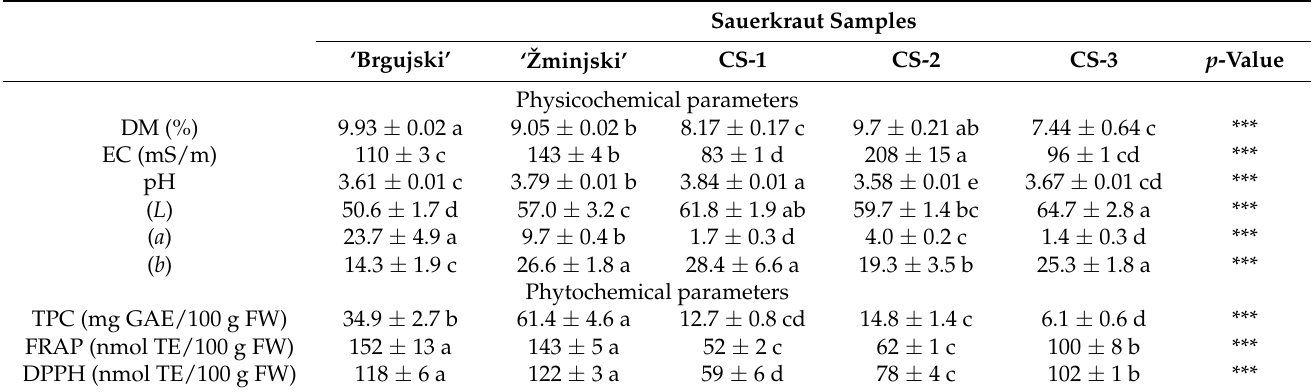
Table 1. Physicochemical and phytochemical parameters of sauerkraut samples ‘Brgujski’ and ‘Žminjski’, and commercial sauerkrauts (CS-1, CS-2, and CS-3). Sauerkraut Samples ‘Brgujski’